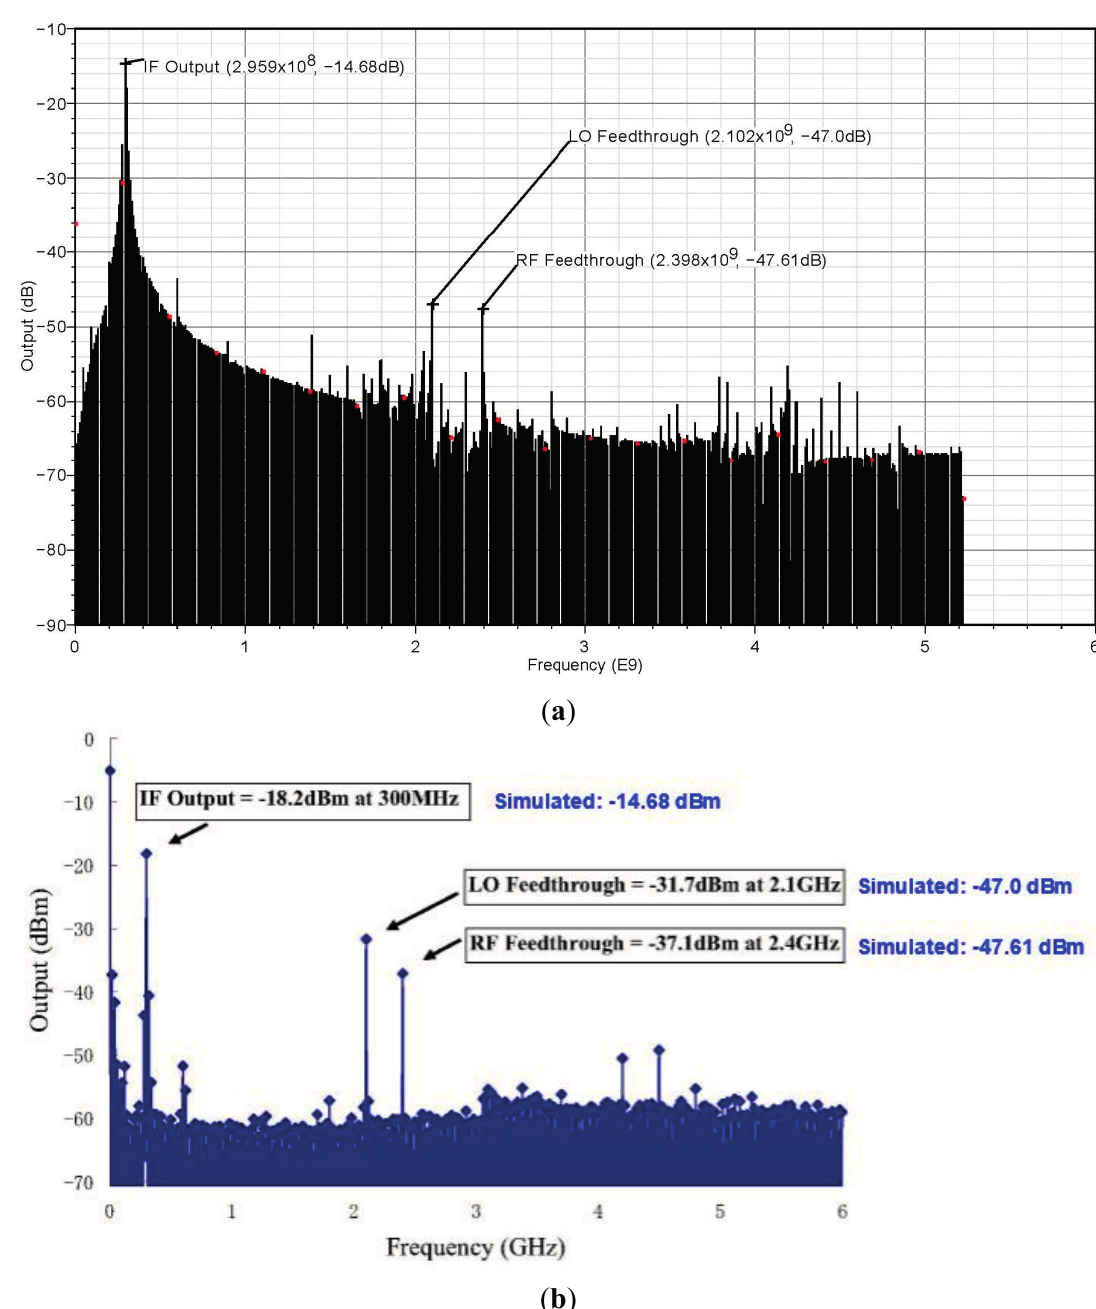
Figure 6. ( a ) Output of the receiver front-end; ( b ) Measured output of receiver front-end from the output data of spectrum analyzer at P in = − 30